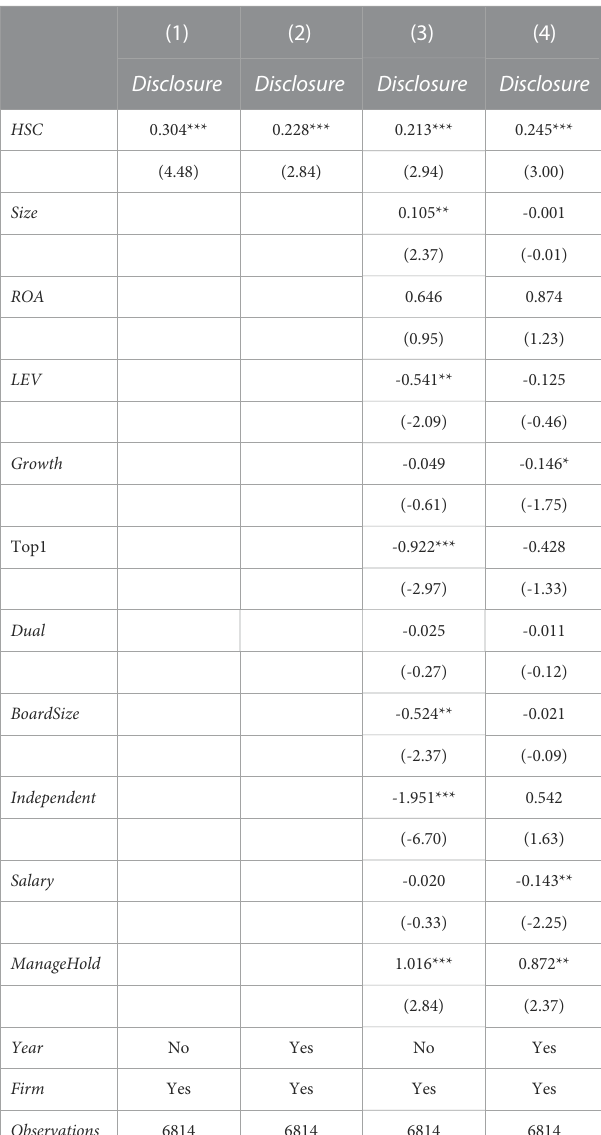
TABLE 3 Basic Results, 2006 – 2019: This table shows the different impact of capital market liberalization on ESG pillars. The dependent variable in column 1 is the environmental ESG score ( E ) which is measured by is a score for the fi rm-level ESG disclosure. The independent variable HSC is a dummy variable thattakesthevalueoneifthe fi rmentersthelistofShanghai-HongKongStock Connect or Shenzhen-Hong Kong Stock Connect, and zero otherwise. Other control variables include fi rm size ( Size ), return on total assets ( ROA ), fi nancial leverage ( LEV ), operation income growth rate ( Growth ), ownership concentration ( Top 1), integration of two positions ( Dual ), board size ( BoardSize ), independent director ratio ( Independent ), top three executives ’ compensation ( Salary ), and management shareholding ratio ( ManageHold ). t -statistics are reported in parentheses below each estimate. ***, ** and * denote signi fi cance levels at 1%, 5% and 10%, respectively.